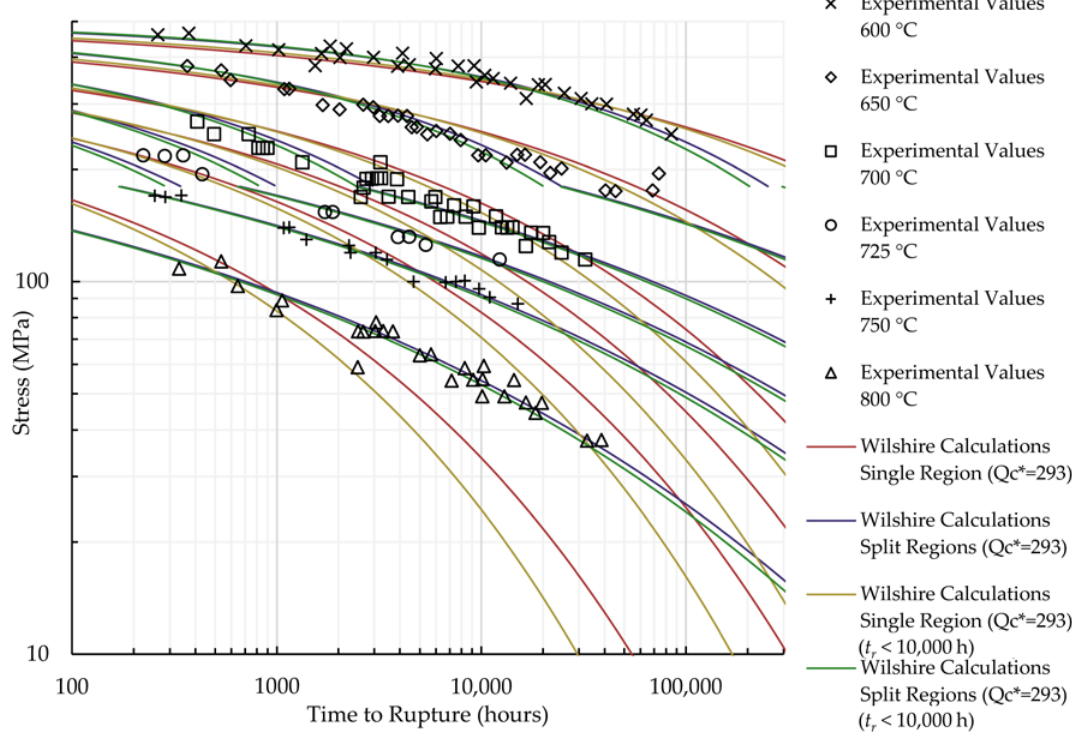
Figure A13. Calculations of the Wilshire equation for Sanicro 25 with the self-diffusion activation energy of austenitic stainless steels as Q ∗